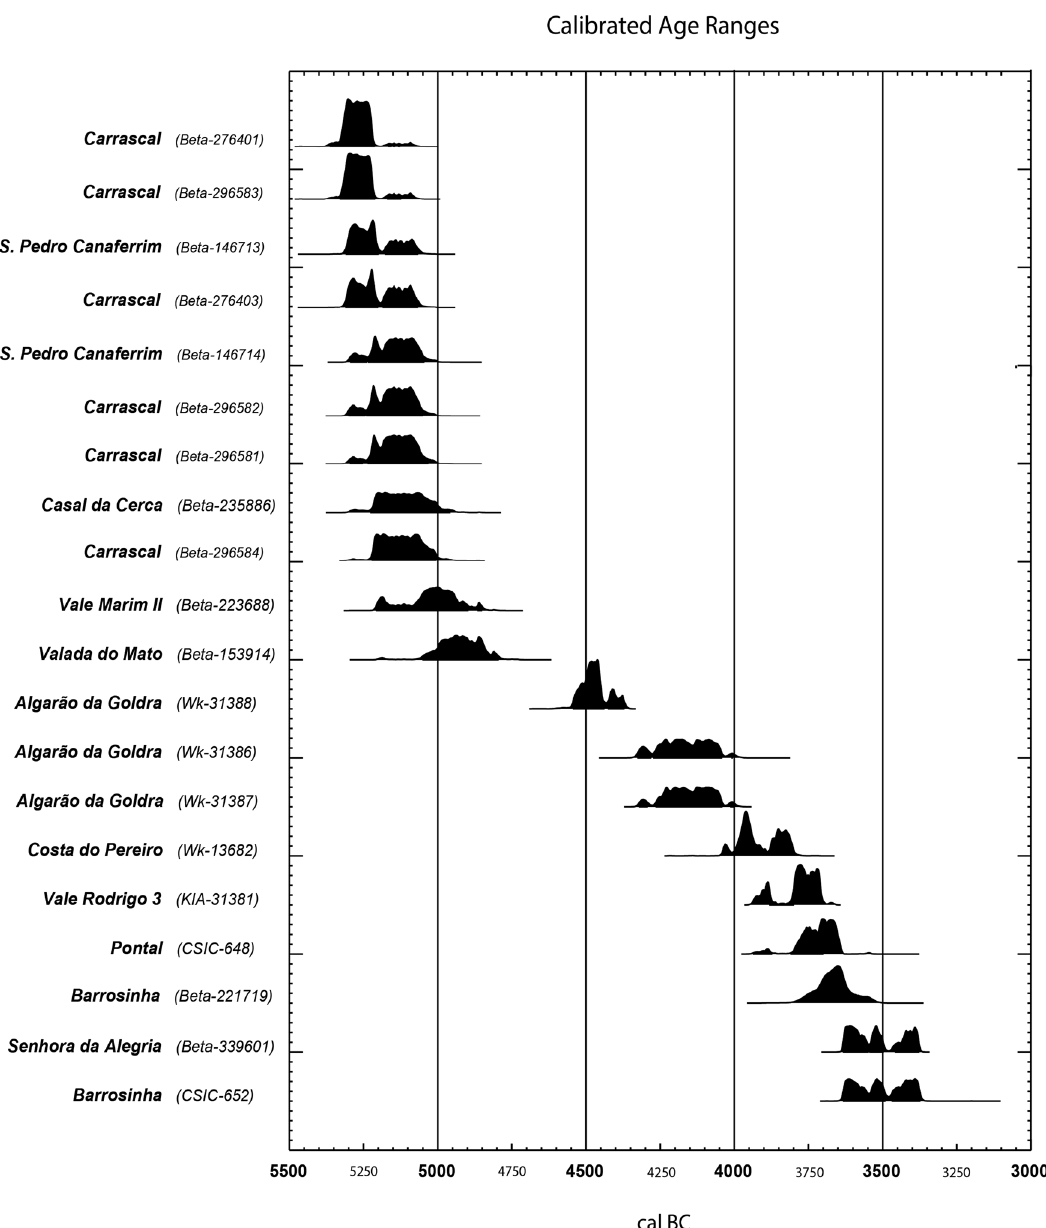
Figure 11: Radiocarbon dates available for domestic sites of Evolved Early Neolithic – Middle Neolithic mention in the text. Calibrated with IntCal13 atmospheric curve ( Reimer et al., 2013 )